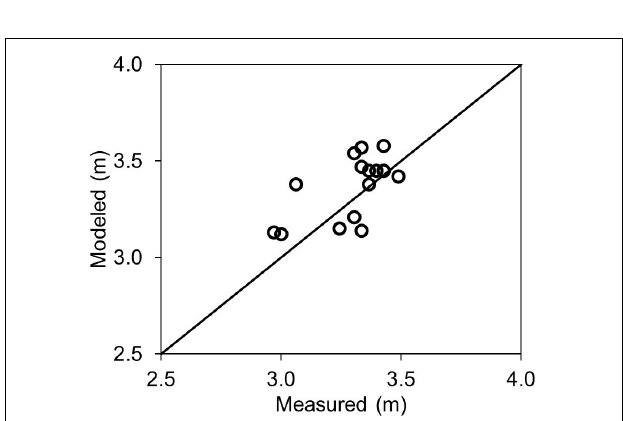
FIGURE 6 | Measured and modeled high-water marks in